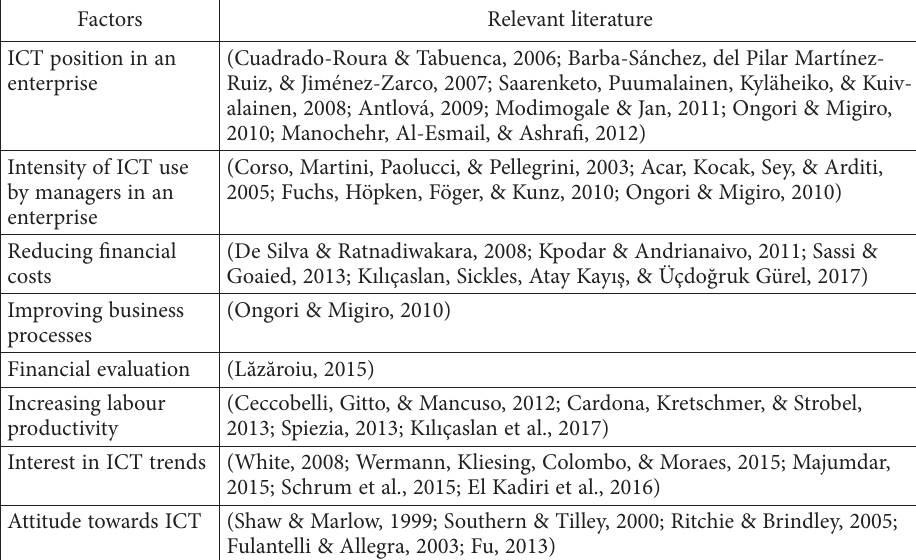
Table 1. Comparison of relevant literature (source: own processing)